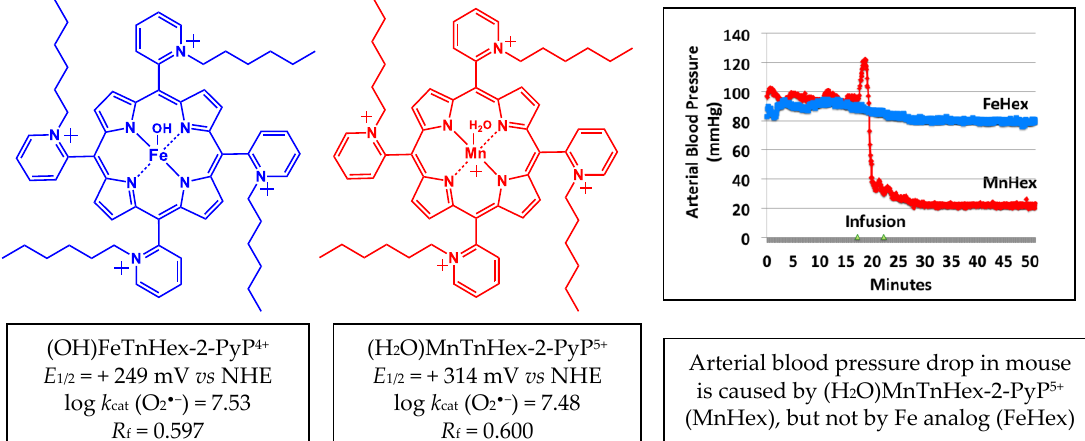
Structures of aqua Mn(III) meso -tetrakis( N -n-hexylpyridinium-2yl)porphyrin, (H 2 O) MnTnHex-2-PyP 5 + and monohydroxo Fe(III) meso -tetrakis( N -n-hexylpyridinium-2yl)porphyrin, (OH)FeTnHex-2-PyP 4 + . Redox properties that determine the ability of these compounds to exhibit therapeutic e ff ects are listed: metal centered reduction potential for M III / M II redox couple, E 1 / 2 in mV vs. NHE ( M = metal) and log value of the rate constant for the metalloporphyrin-driven catalysis of O 2 •− dismutation, log k cat (O 2 •− ). Lipophilicities are also listed, expressed in terms of the thin-layer chromatographic R f , which shows the path of the compound vs the path of the solvent on silica plates